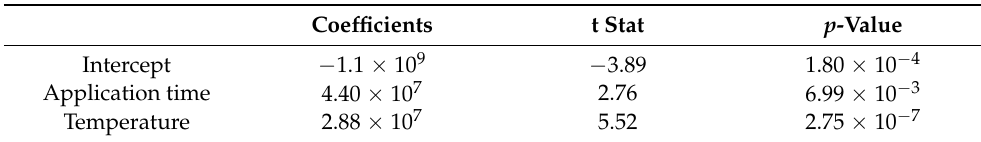
Table 2. Multiple regression analysis between VRE sterilization rates and electrical parameters: part II.